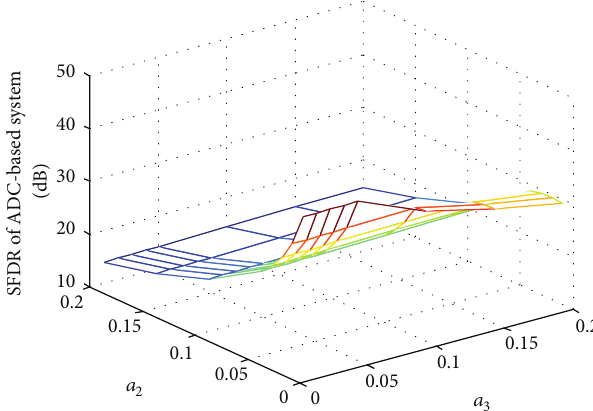
Figure 4: SFDR performance of conventional ADC-based system with other nonlinear effects.